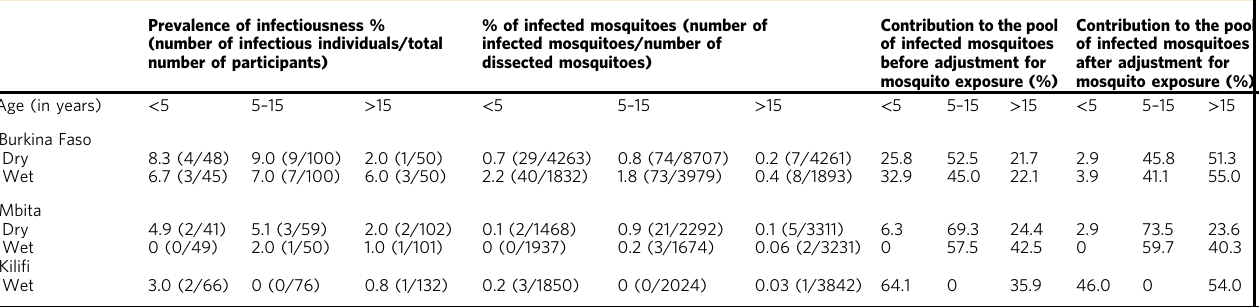
Table 3 Age-speci fi c contributions to local malaria transmission Prevalence of infectiousness % (number of infectious